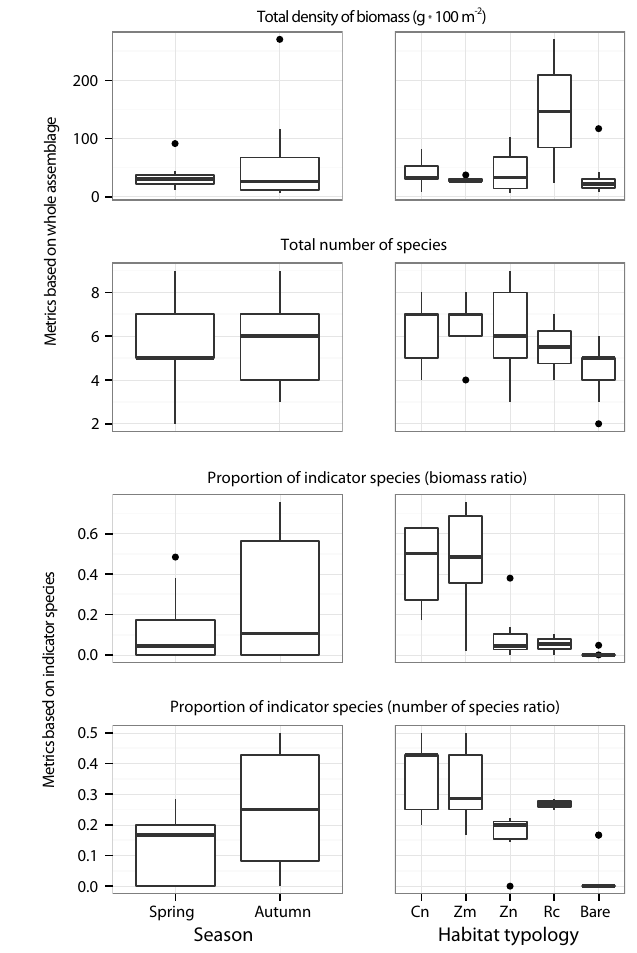
Figure 2. Distribution among seasons and habitat typologies of candidate metrics based on the whole fish assemblage and on in- dicator species. Habitat typologies are abbreviated as follows: Cn: Cymodocea nodosa ; Zm: Zostera marina ; Zn: Zostera noltei ; Rc: Ruppia cirrhosa. ; Bare: bare